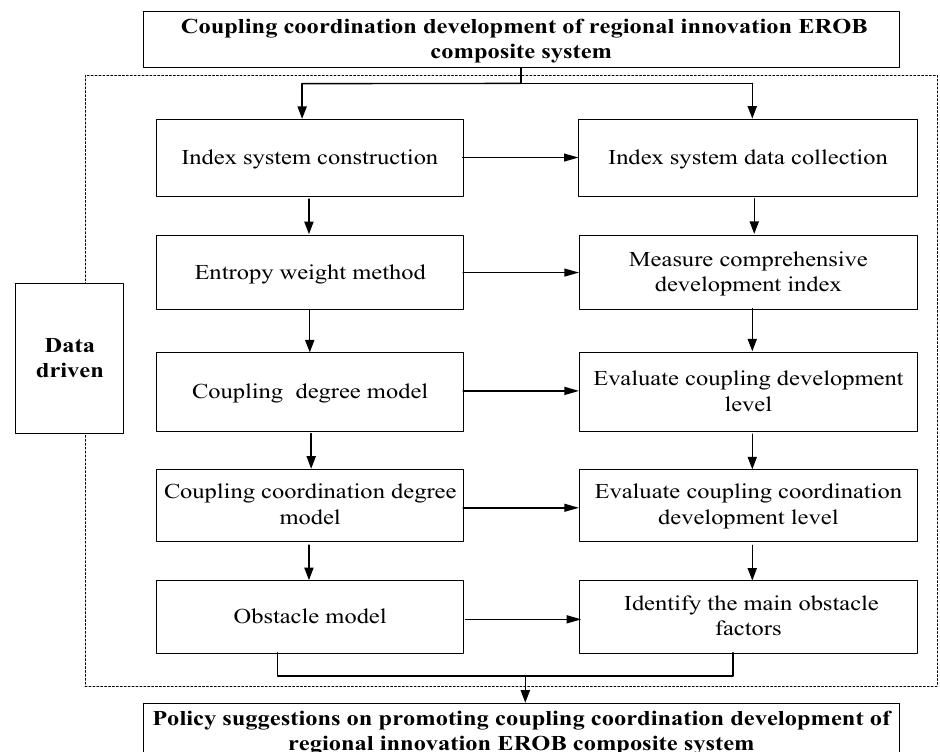
Figure 2. Data application diagram.